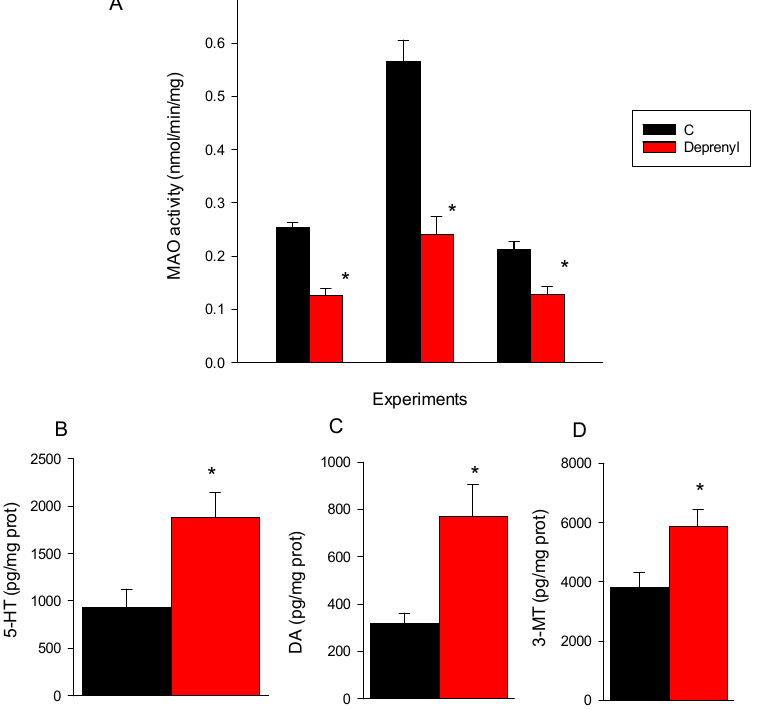
Figure 3. Effects over enzyme activity ( A ) and monoaminergic neurotransmitter levels ( B – D ) (means ± SE, n = 5–10) in the whole body of the D. magna juveniles following 24 exposures to 1 mg/L of deprenyl. For clarity, monoaminergic neurotransmitters that showed a significant change across treatments are depicted. The rest of the values are provided in Table S3, Supplementary Materials. Note: * the indicated bars mean significant ( p < 0.05) treatment differences relative to the controls following the Student’s t -test.